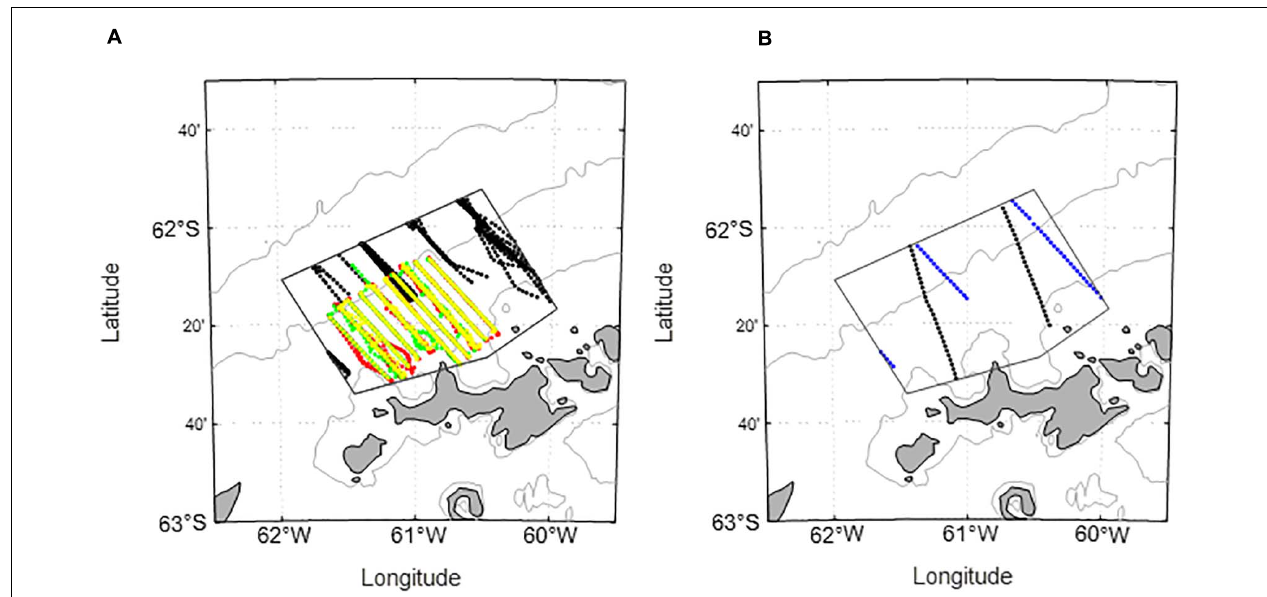
FIGURE 3 | Bathymetric charts (250, 1000, and 3000 m isobaths) of the West Shelf illustrating the overlap of ship-based surveys with the area sampled by a glider during 2019/19. (A) Black points indicate coverage by previous, broad-scale surveys conducted by the U.S. AMLR Program within the restricted polygon subsequently sampled by a glider. Colored points represent the data collected during three [2005 (red), 2006 (green), and 2007 (yellow)] nearshore surveys. (B) Coverage by a multi-ship acoustic survey conducted during 2018/19 within the polygon contemporaneously sampled by a glider. Black points are from a January 19 transit by one ship, and blue points are from a March 05 transit by a second